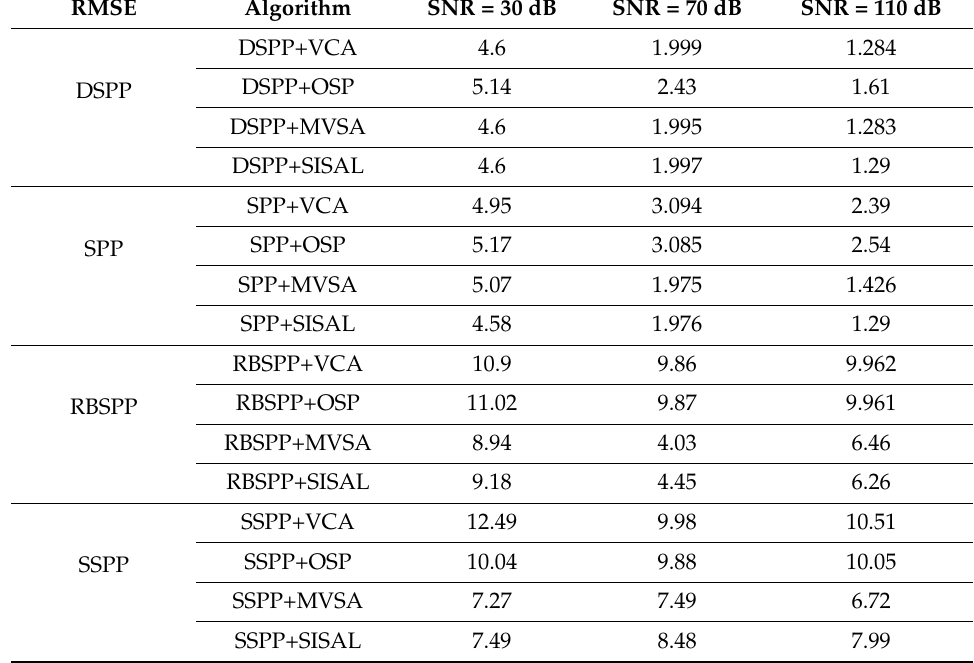
Table 2. RMSEs of reconstructed images using different SNRs and different algorithms. RMSE